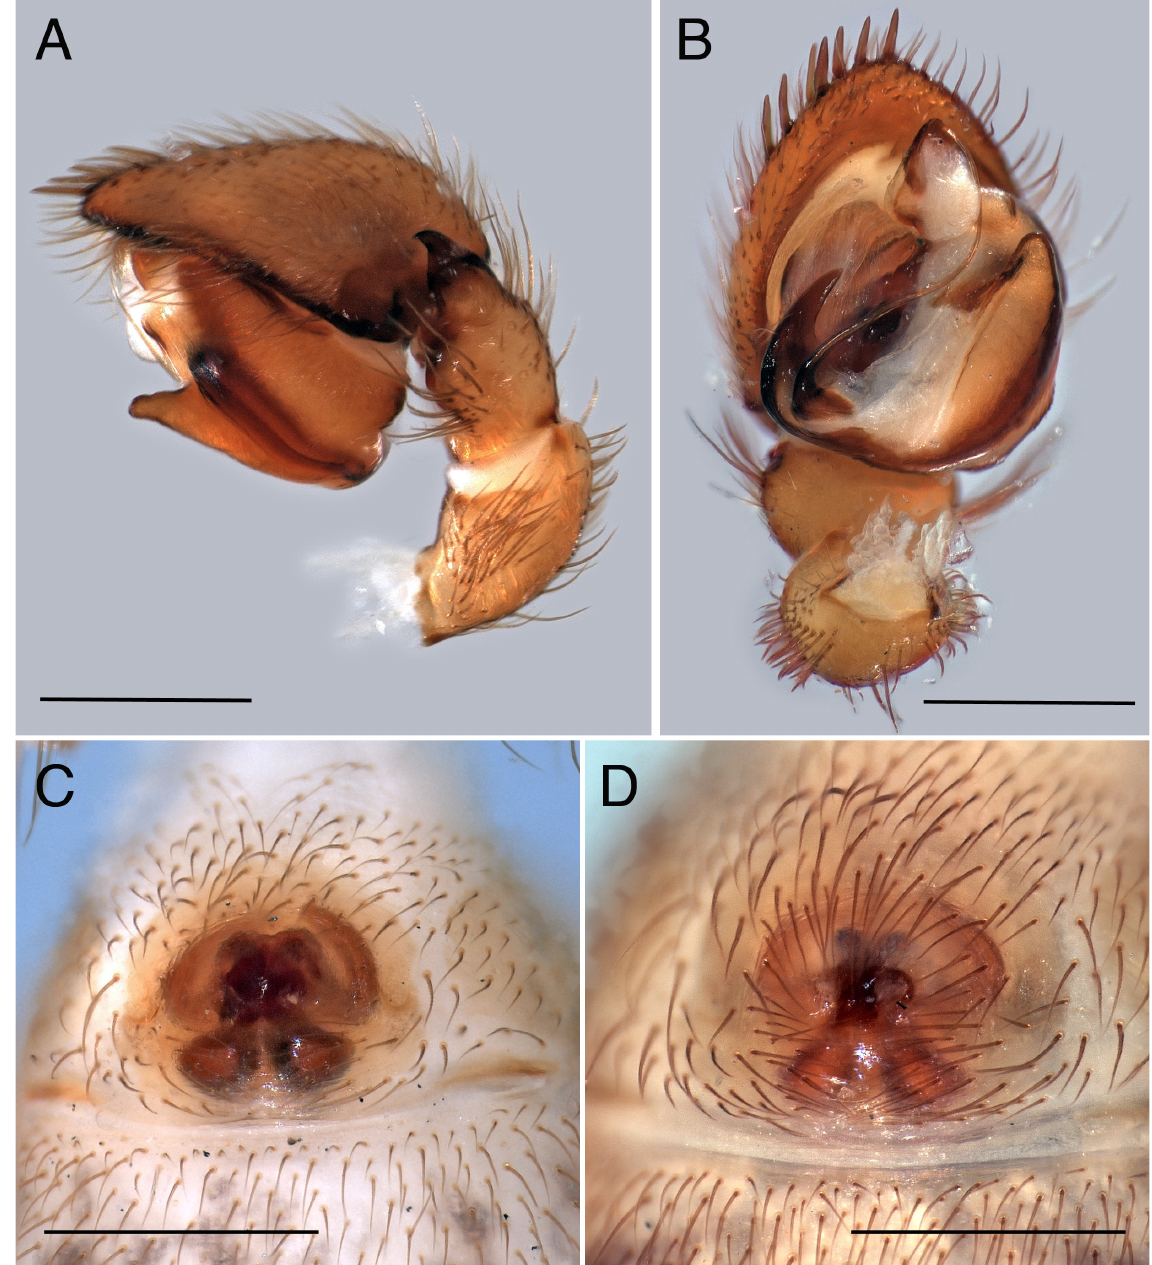
Fig. 8. Ballomma haddadi gen. et sp. nov. A–B . Holotype, ♂. C–D . ♀♀ (MRAC 132641). A . Male palp, retrolateral view. B . As preceding, ventral view. C . epigyne, ventral view. D . As preceding, other specimen. Scale bars: 0.5